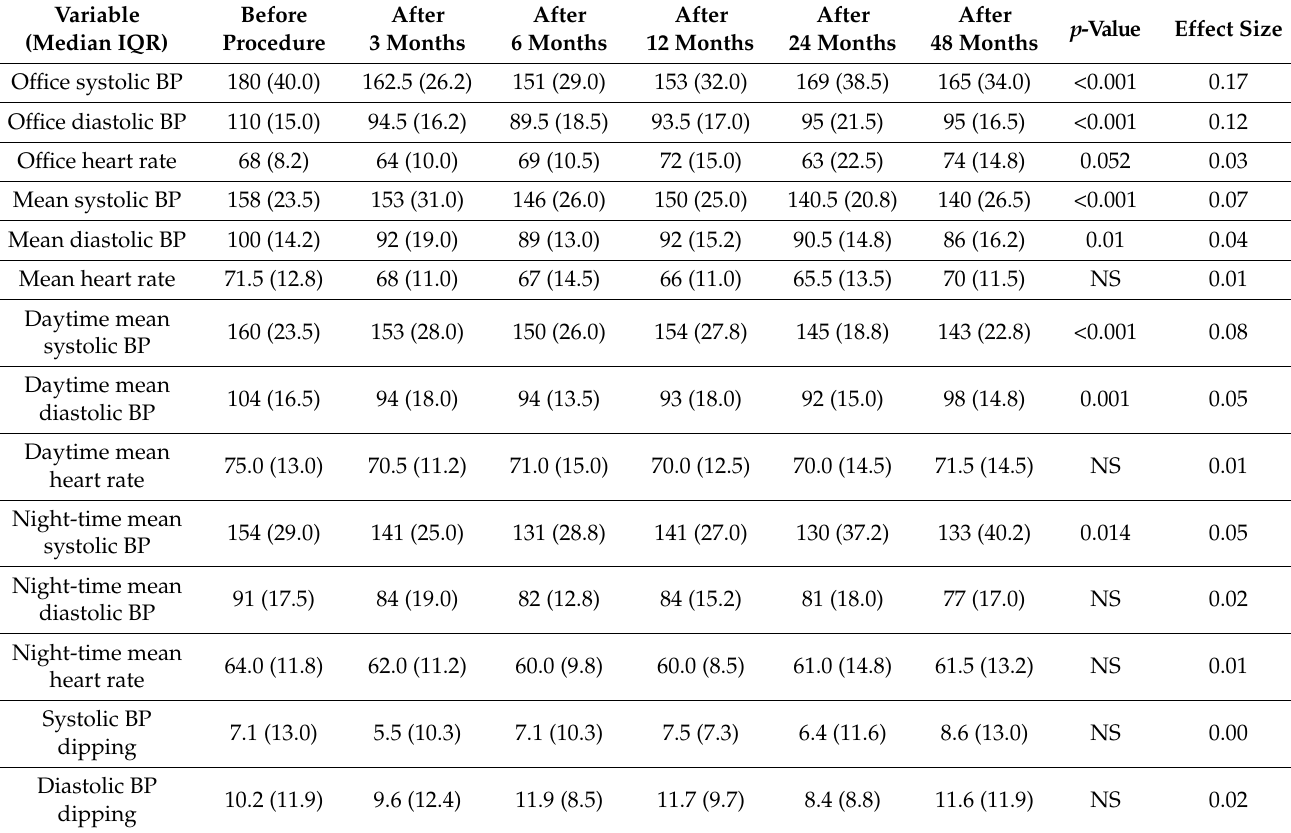
Figure 1. Office systolic blood pressure (BP) changes after renal artery denervation (RDN) (mmHg). Table 2. Main blood pressure parameters over observation period.